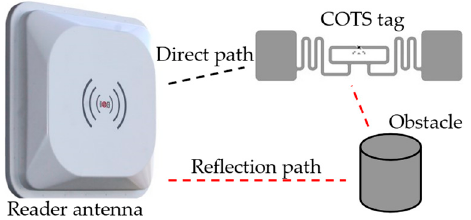
Figure 6. Multipath effect in RFID.